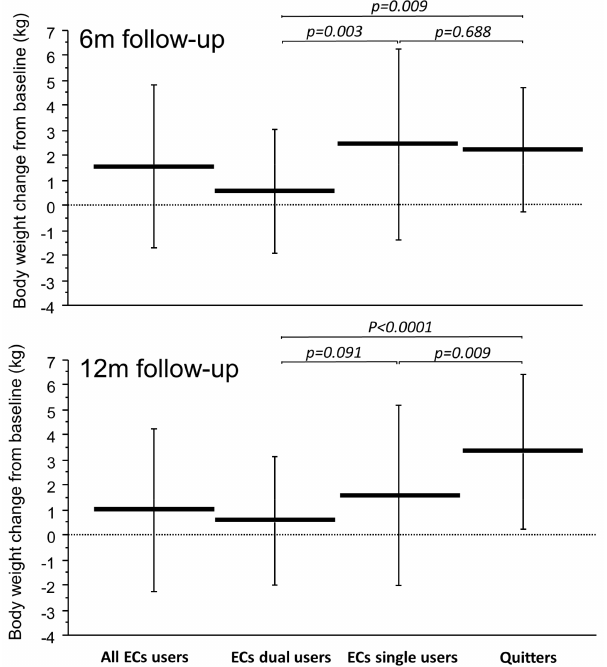
Figure 1. Absolute body weight changes from baseline at 6 (upper panel) and at 12 (lower panel) months follow-up separately for all EC users, EC dual users, exclusive EC users (i.e., single users), and Quitters. Horizontal and vertical lines indicate means and standard deviations, respectively. p -values were computed by means of one-way Analysis of Variance and Fisher’s Least Significant